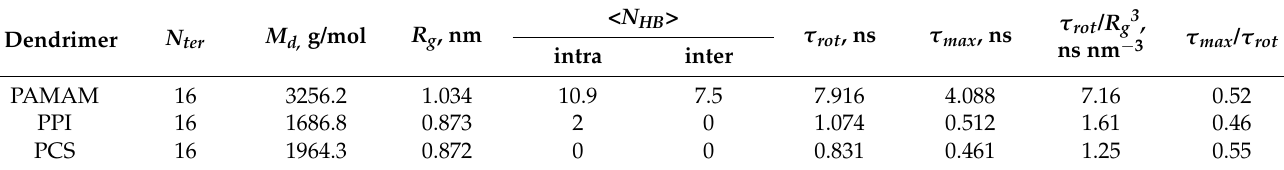
Table 1. Structural and dynamic characteristics of the second generation PAMAM, PPI and PSC dendrimers. The number of terminal groups, N ter , the molecular weight, M , the radius of gyration, R g , the rotational relaxation time, τ rot . The terminal (maximal) time of mechanical relaxation, τ max , characterizing the tail of the relaxation modulus of dendrimers ( G(t) ~exp( − 2t/ τ max )). The average number of hydrogen bonds per one dendrimer, <N HB >, within the macromolecule (intra) and number of external hydrogen bonds between macromolecules (inter). Note that the intramolecular hydrogen bond is counted twice (for the donor and acceptor) per dendrimer, as well as the intermolecular hydrogen